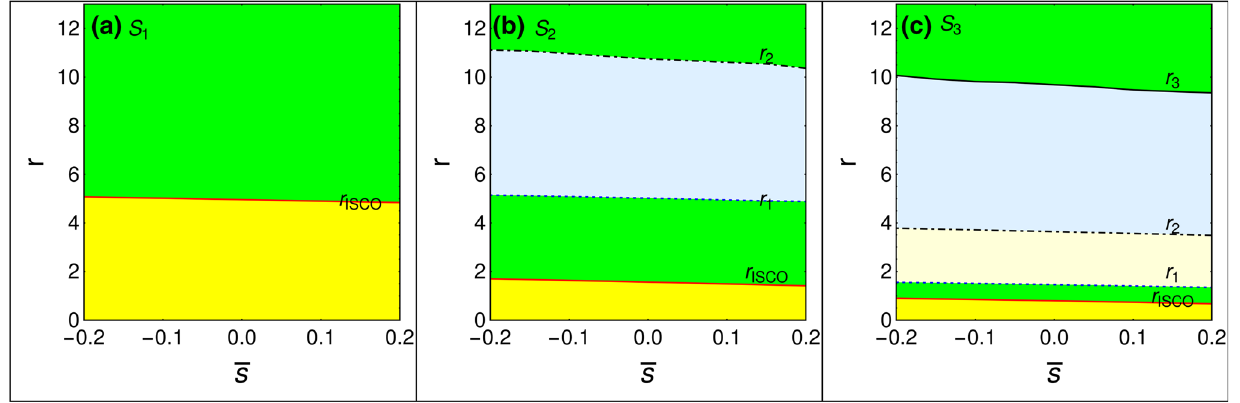
like circular orbits in the green region, there are no timelike circular orbits in the lightyellow region, there are unstable circular orbits in lightblue